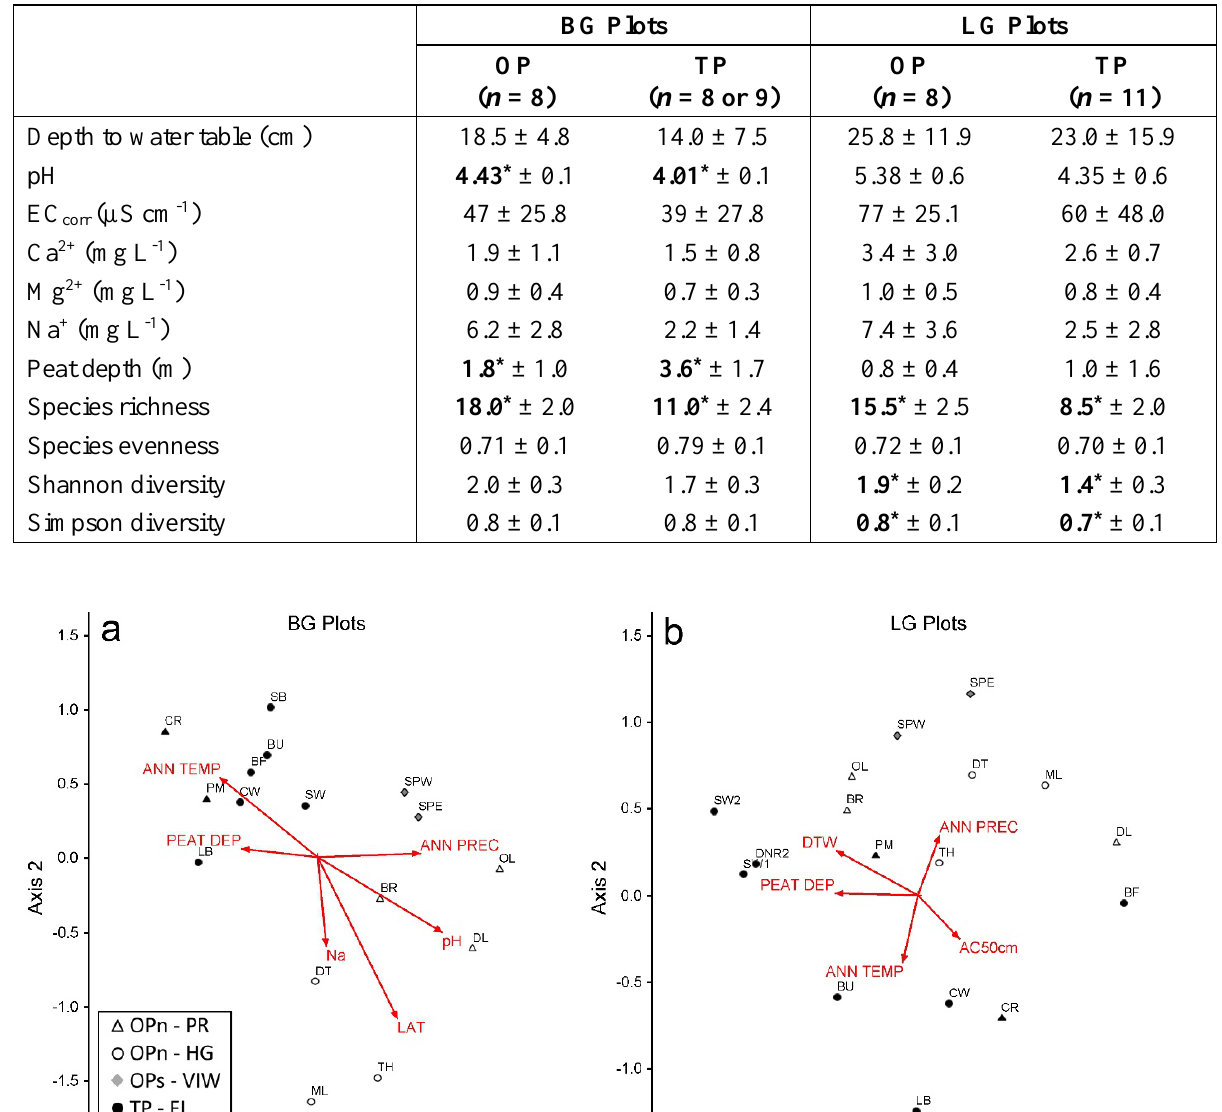
Table 1. Median ± mean absolute deviation of the environmental factors and plant species diversity indices for the BG (bog) and LG (lagg) plots. Pacific Oceanic (OP) and Pacific Temperate (TP) wetland regions are compared side by side; an asterisk (*) and bold text indicates a significant (P < 0.05) difference between the two wetland regions. For TP, n = 8 for depth to water table and hydrochemistry, and n = 9 for peat depth and the diversity indices.